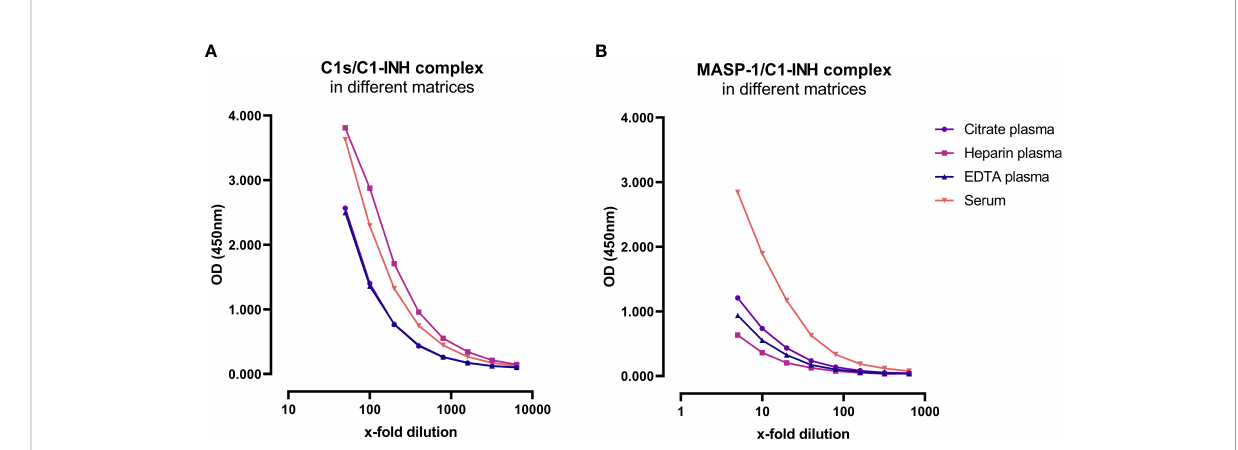
FIGURE 3 C1-INH complex concentrations in different matrices. Exemplary results of Citrate plasma (purple), Heparin plasma (pink), EDTA plasma (blue) and serum samples (red) from a single individual are plotted in a dilution range from 50x-6400x for the C1s/C1-INH complex (A) and in a dilution range from 5x-640x for the MASP-1/C1-INH complex (B) . In fl uence of matrices on C1-INH complex concentrations was investigated in two individuals, while results of one individual each are shown here as an example. OD, optical density; EDTA, Ethylenediaminetetraacetic acid; nm,